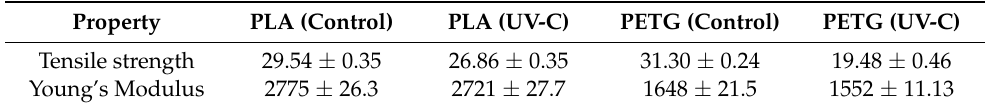
Table 3. Tensile strength and stiffness.